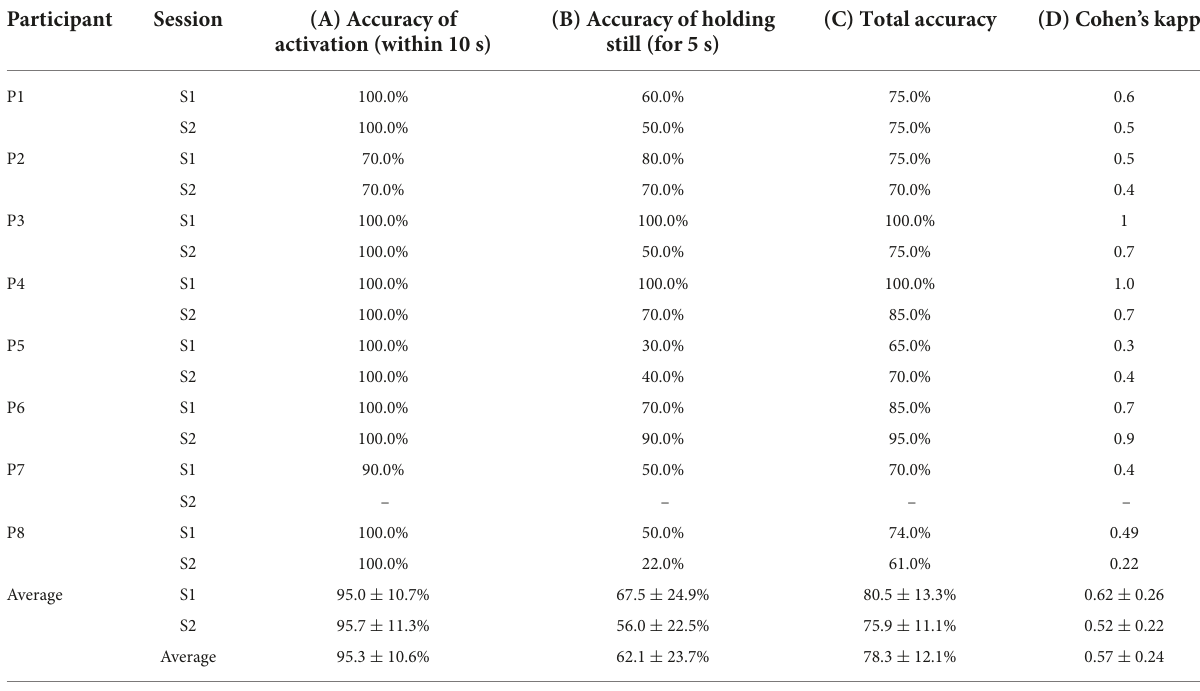
TABLE 4 Accuracy of (A) activating the power mobility trainer device (PMTD) within 10 s of cueing, (B) holding the PMTD still for 5 s after cueing, (C) total accuracy across both activating and holding still, (D) kappa score across both activating and holding still. Participant